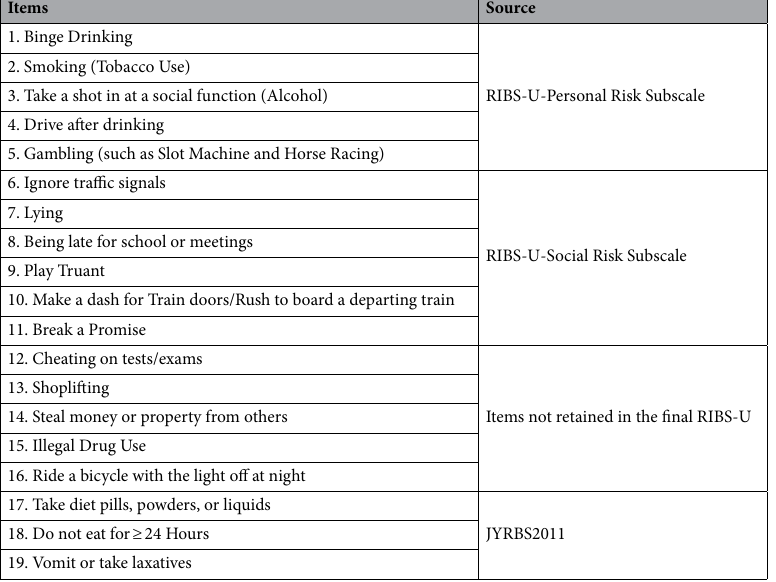
Table 5. Source of the initial 19 items for the GRTQ. All questions were distributed in pseudorandom order in the data collection process. RIBS-U: Risk-taking Behavior Scale for Undergraduates. JYRBS2011: Japanese Youth Risk Behavior